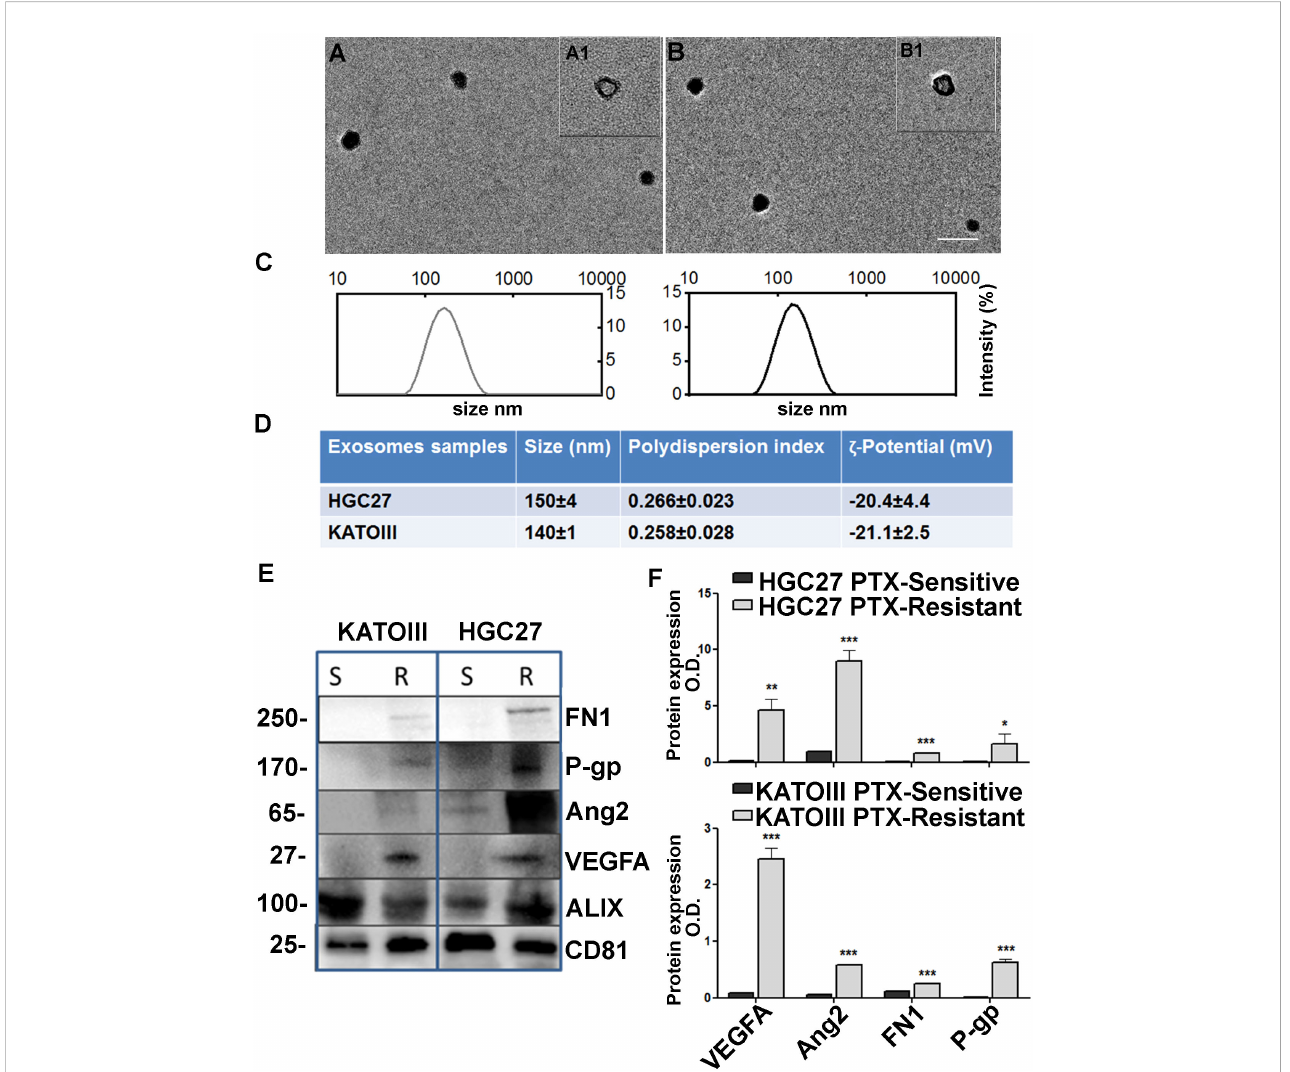
FIGURE 7 Exosome characterization. TEM micrographs (scale bar 200 nm) of exosomes extracted from culture medium of KATOIII cells (A) and HCG27 (B) at two different staining times 30 s ( A1 , B1 ) and 60 s ( A , (B) ; (C) DLS-intensity distribution of exosomes derived from KATOIII and HGC27 respectively; (D) Table reporting the data obtained by DLS analysis and z -potential measurements (Mean ± SD, n = 3); (E) The representative WB for exosomes cargoes proteins extracted from KATOIII and HGC27 both sensitive and resistant to the PTX, namely: FN1, P-gp, Ang2, VEGFA and housekeeping proteins for exosomes namely ALIX and CD81; (F) The graphs represented the WB bands densitometry normalized for CD81 for HGC27 (upper graph) and KATOIII. For each protein, statistical analysis was assessed comparing the normalized value of PTX-resistant cells to that of sensitive ones, ***p<0.001; **p<0.01;